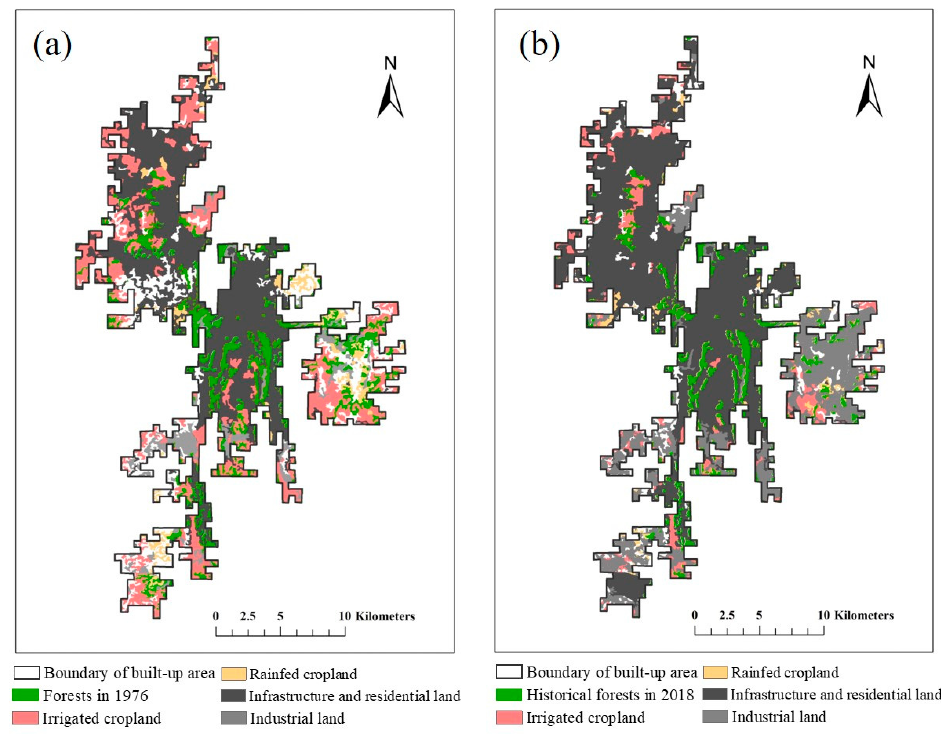
Figure 3. Location of threat sources in ( a ) 1976 and ( b ) 2018.